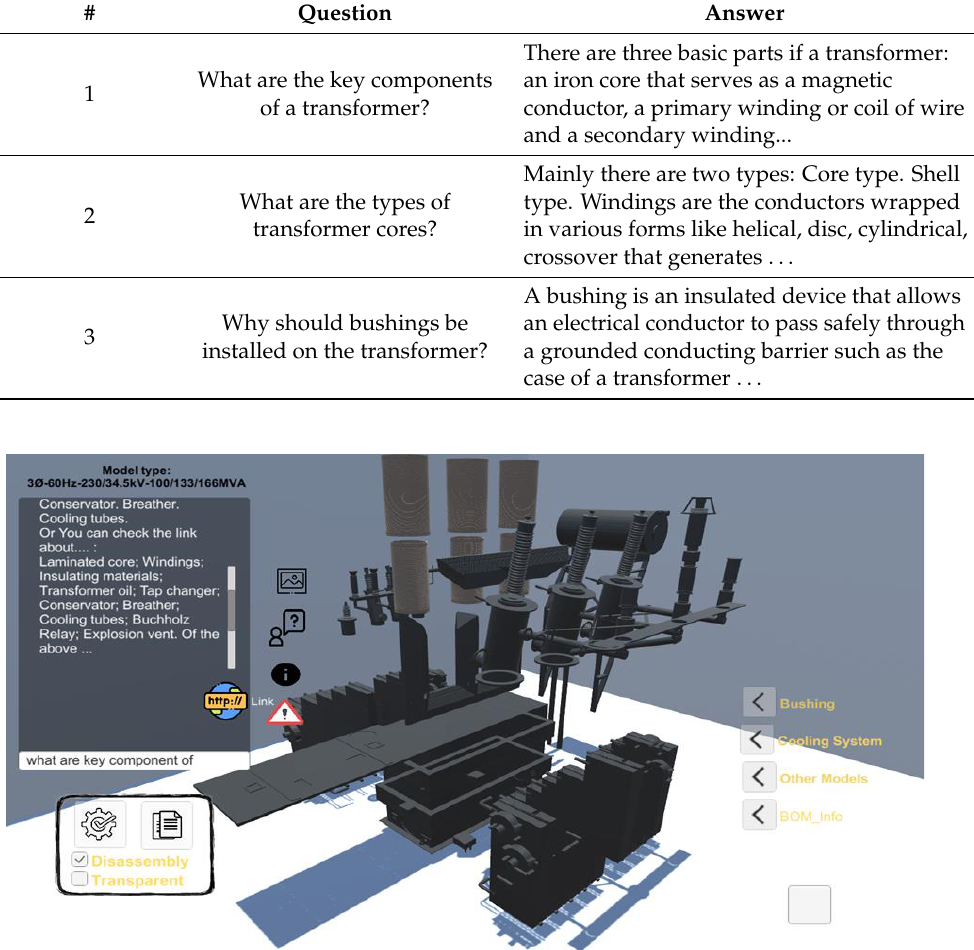
Figure 13. VR immersive interface with chatbot dialog window.